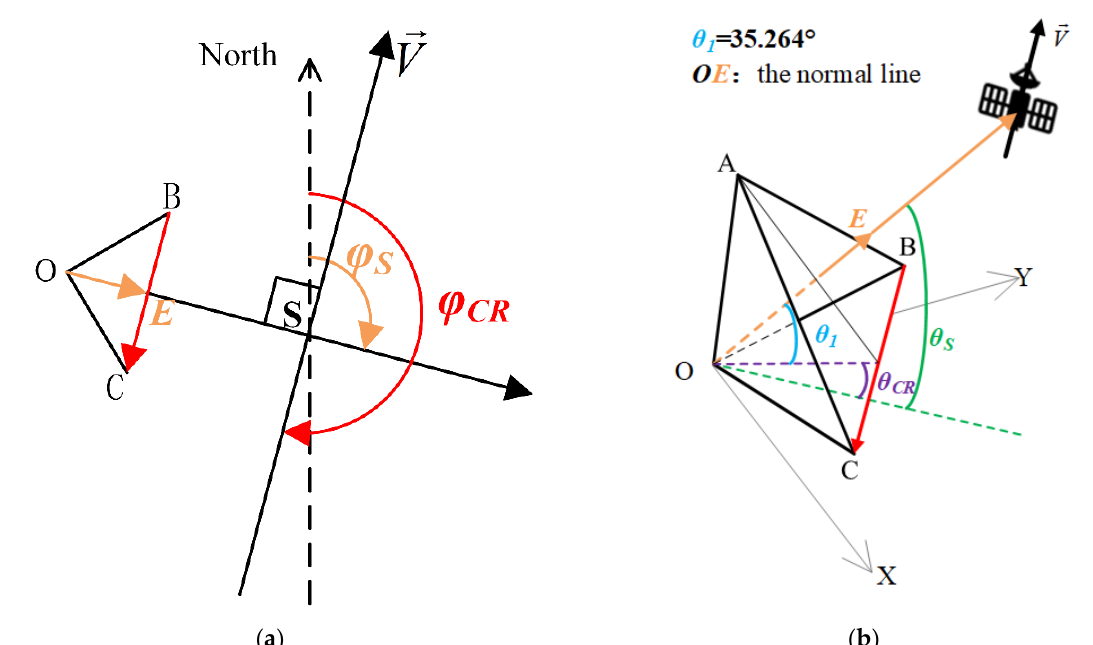
Figure 5. Schematic of trihedral CR azimuth and elevation angle calculation (an example of the ascending orbit left look). These charts are: ( a ) azimuth angle calculation, and ( b ) elevation angle calculation.